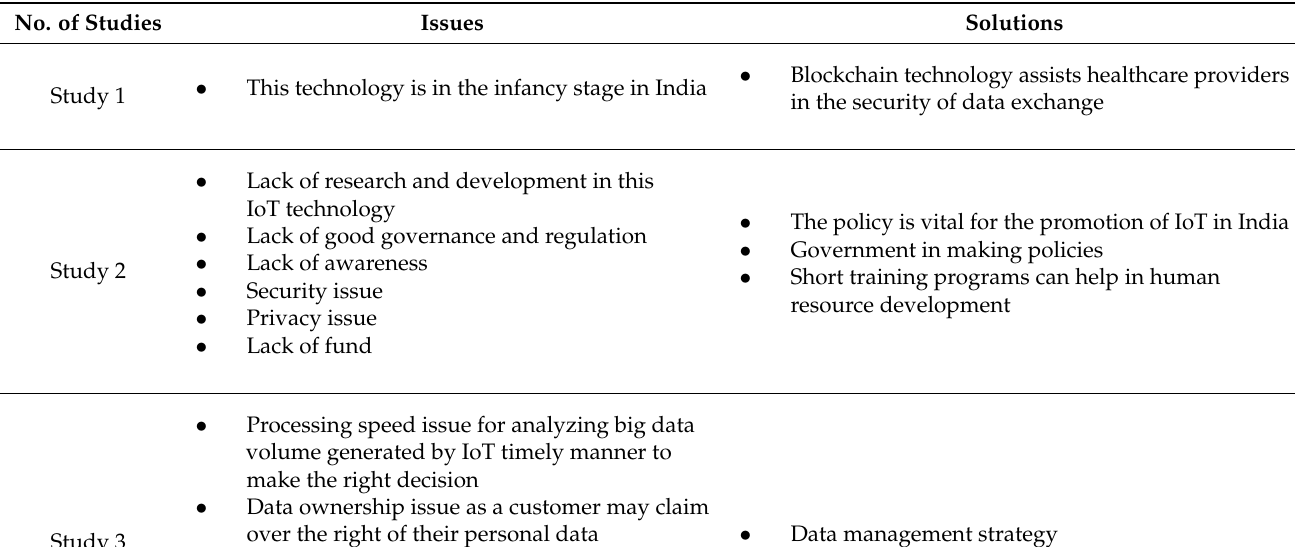
Table 3. IoT adaption in Indian insurance industry: issues and